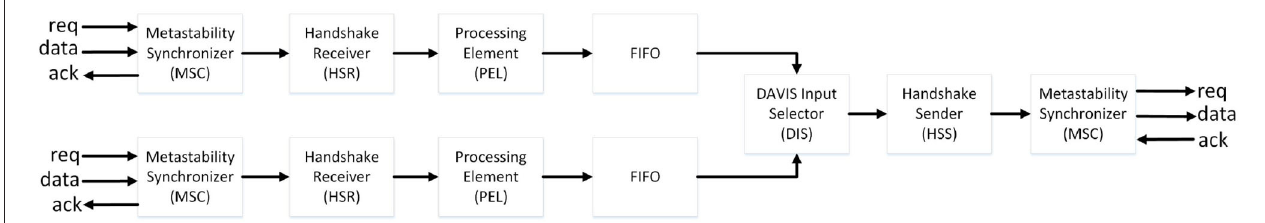
FIGURE 2 | Overview of the event-based digital